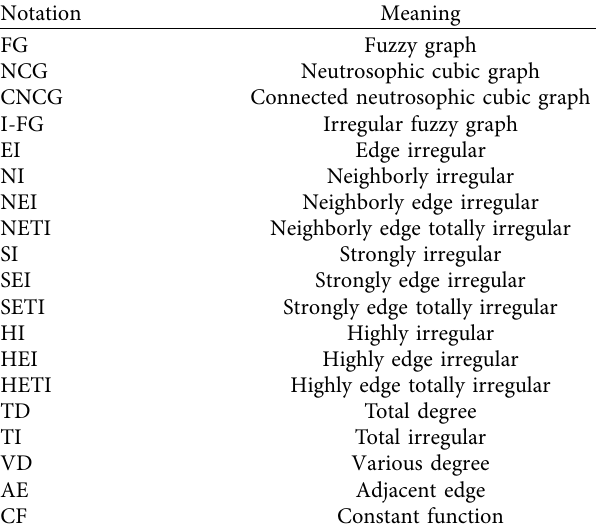
Table 1: Some basic